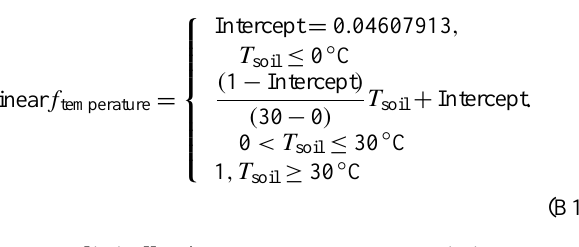
(leaf and root litter age) for leaf and root litter or of woodage (stem litter age) for wood litter (Potter et al., 1993).